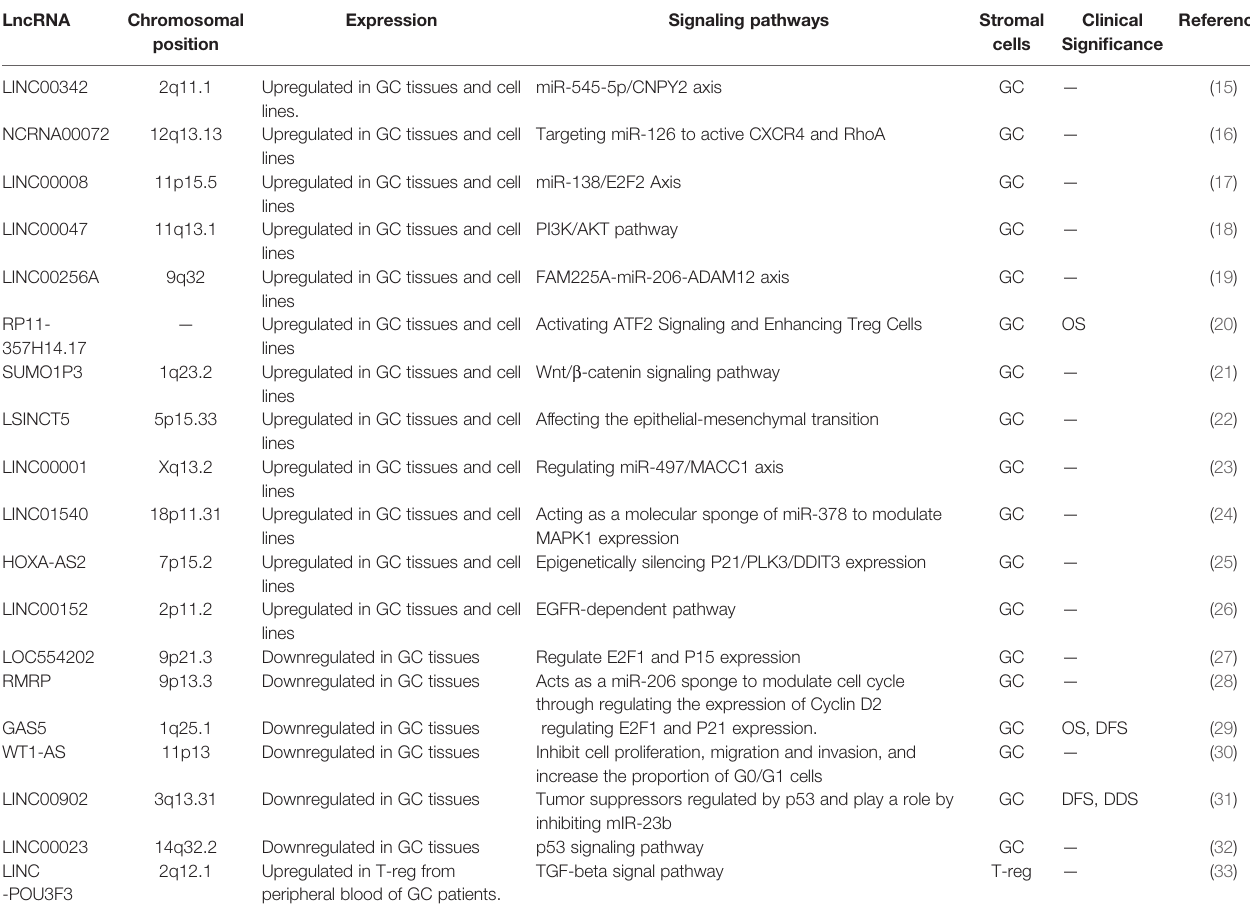
TABLE 1 | LncRNAs involved in GC